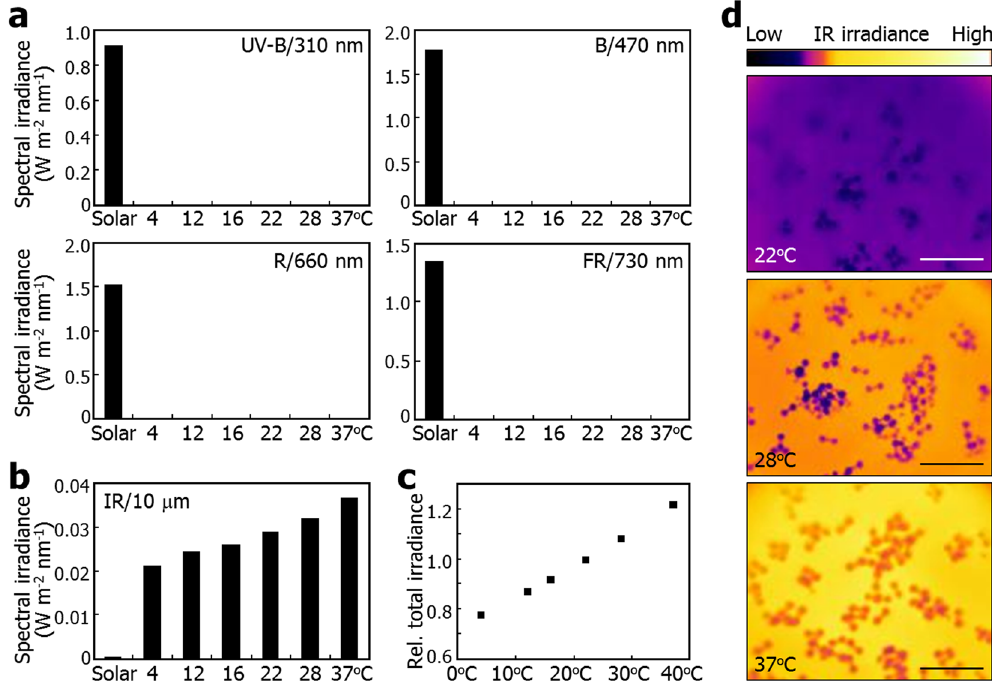
Figure 2. Plants emit IR thermal radiation in proportion to temperature. In ( a ) and ( b ), spectral irradiance values were plotted against environmental temperatures at different physiological wavelengths using the data from Table 1. ( a ) Spectral irradiance of thermal radiation in the UV-B and visible wavelength ranges. ( b ) Spectral irradiance of thermal radiation at 10 mm in the IR range. ( c ) Total spectral irradiance of thermal radiation. Total spectral irradiance was calculated by integrating the spectral irradiance values with respect to the wavelength range at each temperature given in Fig. 1a. ( d ) IR thermal imaging of Arabidopsis seedlings at different temperatures. Six-day-old seedlings were subsequently incubated at the indicated temperatures for 1 h. IR images were recorded in the wavelength range of 7.5~13 mm by a forward-looking IR camera. Scale bars = 20